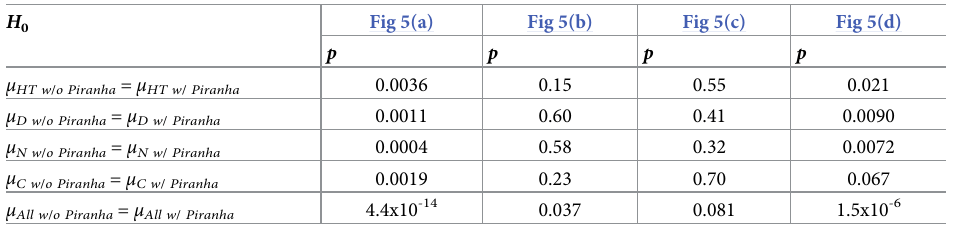
Table 1. P-values and null hypotheses relating to Fig